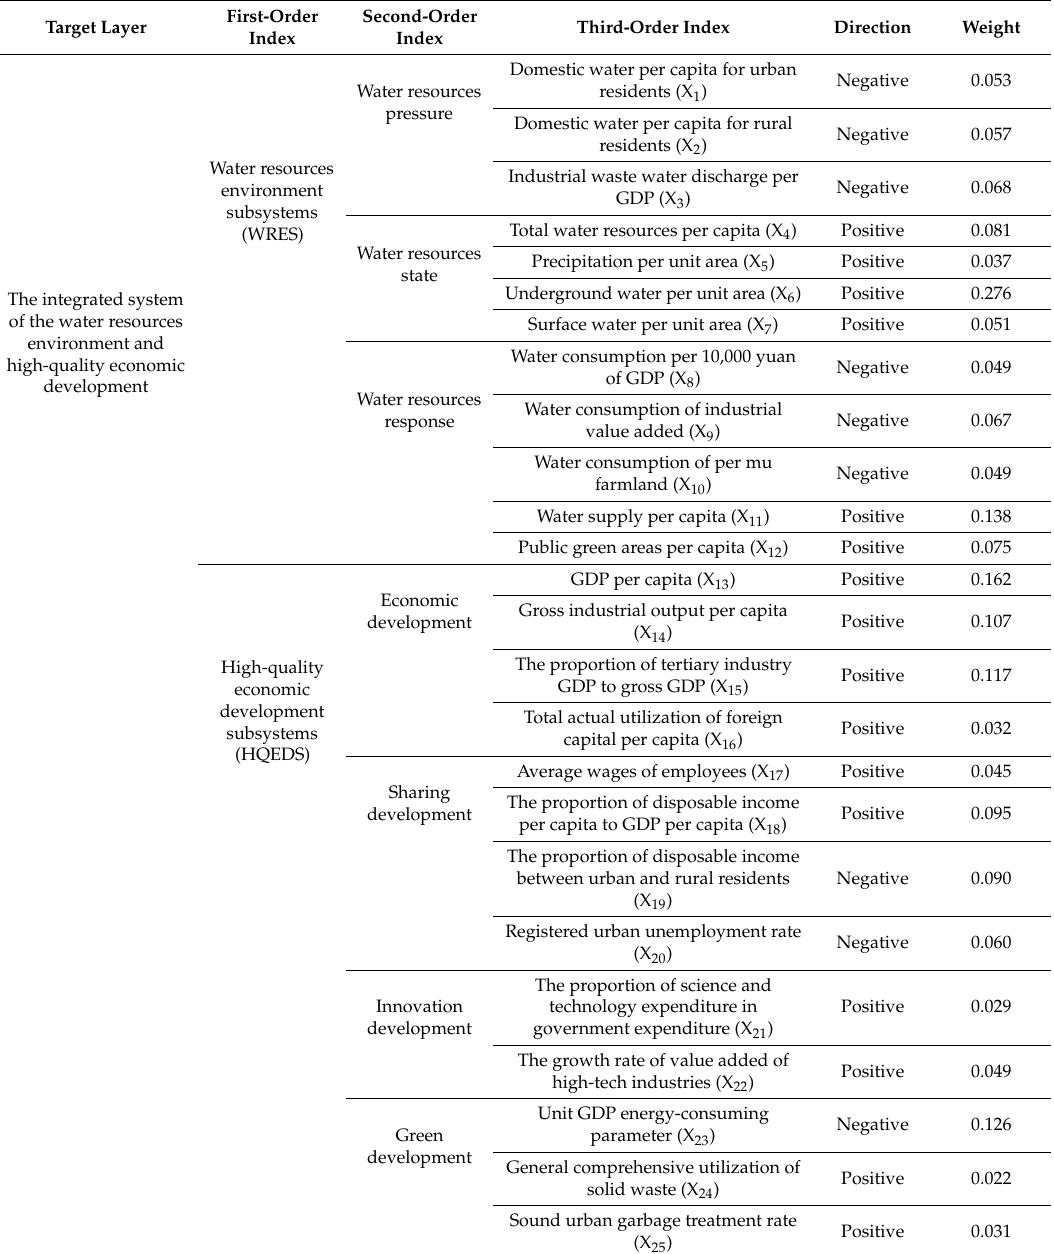
Table 1. Integrated evaluation index system of the water resources environment and high-quality economic